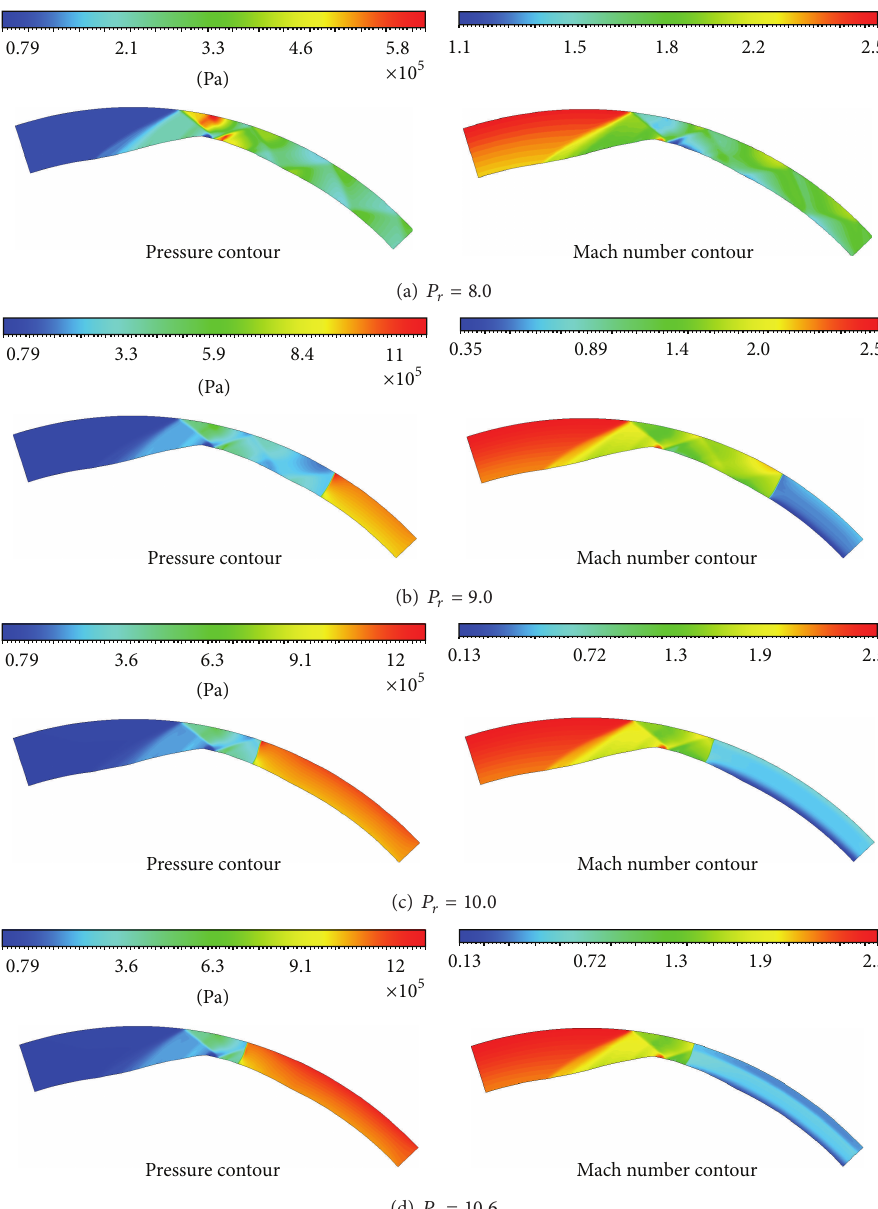
Figure 8: Flow distribution of Rampressor inlet in different 𝑃 𝑟